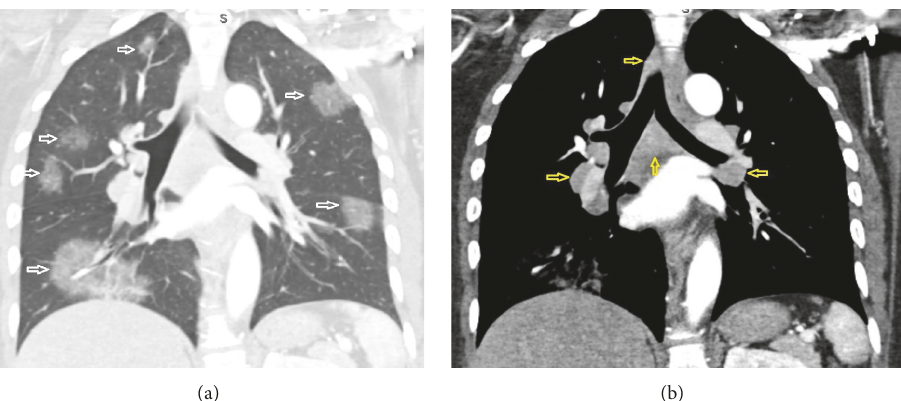
Figure 3: Coronal reformatted image from contrast-enhanced CT scan, with lung window (a), redemonstrating the findings in Figure 2 (white arrows), and with soft tissue window (b) demonstrating lymphadenopathy in the right paratracheal, bilateral hilar, and subcarinal regions (yellow arrows).